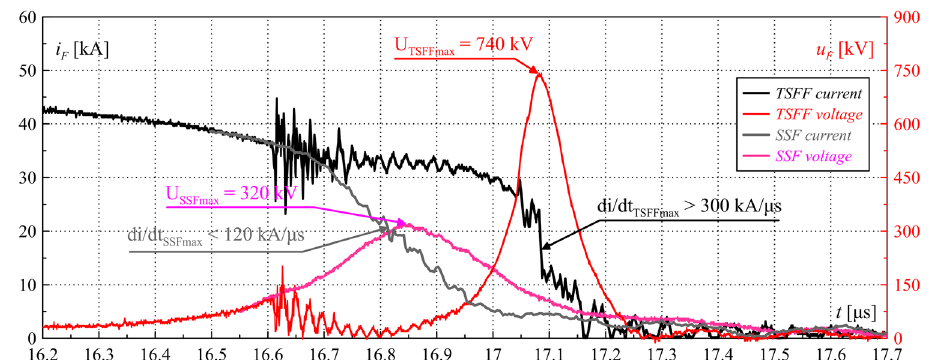
Figure 17. Comparing waveforms of the TSFF and single-stage fuse (SSF) current i F and voltage u F during operation—laboratory test results. Characteristic values are marked in the figure. Close-up on the current limiting